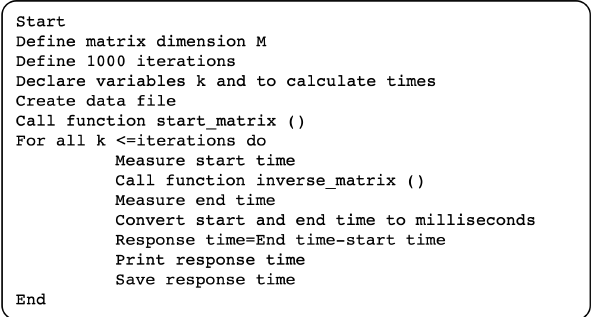
Figure 2. Pseudocode of the matrix inversion algorithm for response times